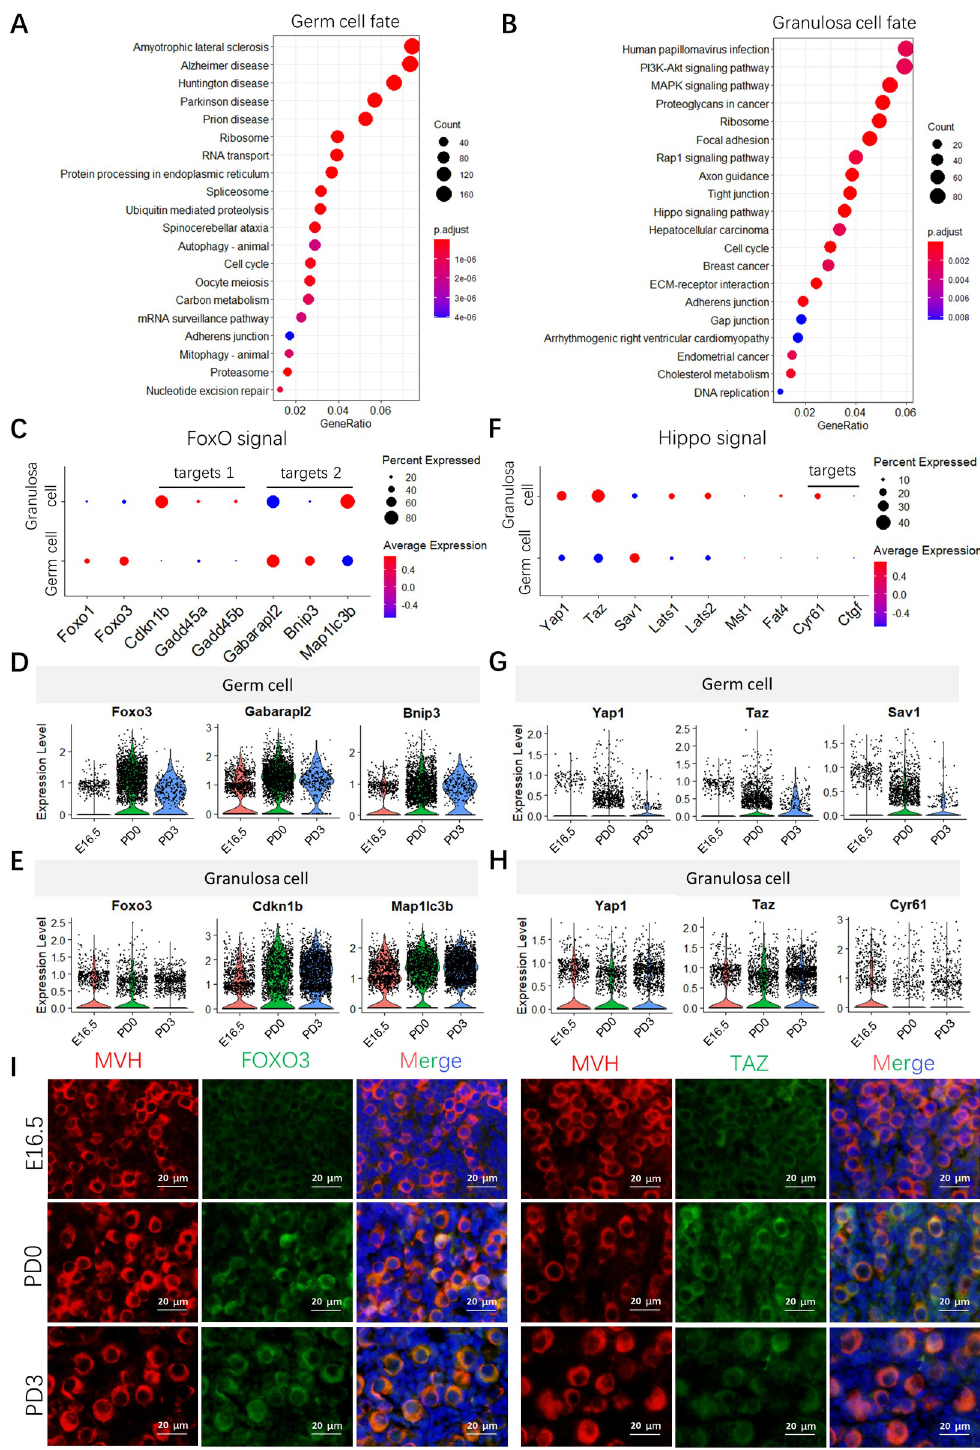
Fig 7. Enrichment molecular pathways of oocytes and granulosa cell subsets during follicle assembly. ( A and B ) Pathway enrichment of key genes regard to fate transitions of germ cells ( A ) (total of 5,881 genes at branch point) and granulosa cell ( B ) (total 3,200 genes at branch point). More pathways are shown in S10 Table. ( C ) Dot plots of FoxO signal and its target genes in germ cell and granulosa cell clusters. ( D and E ) Expression of representative genes of the FoxO signal in germ cells ( D ) and granulosa cells ( E ). ( F ) Dot plots of the Hippo signal in germ cells and granulosa cells. ( G and H